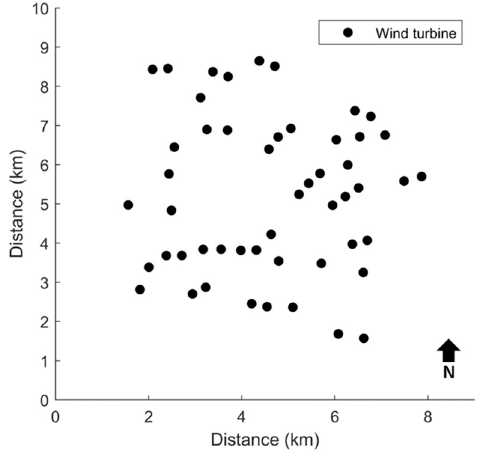
Figure 4. Case study wind farm layout.